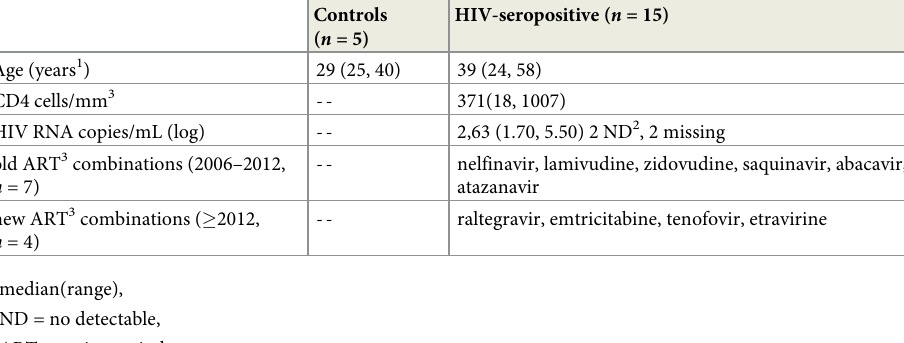
Table 1. Participant characteristics.